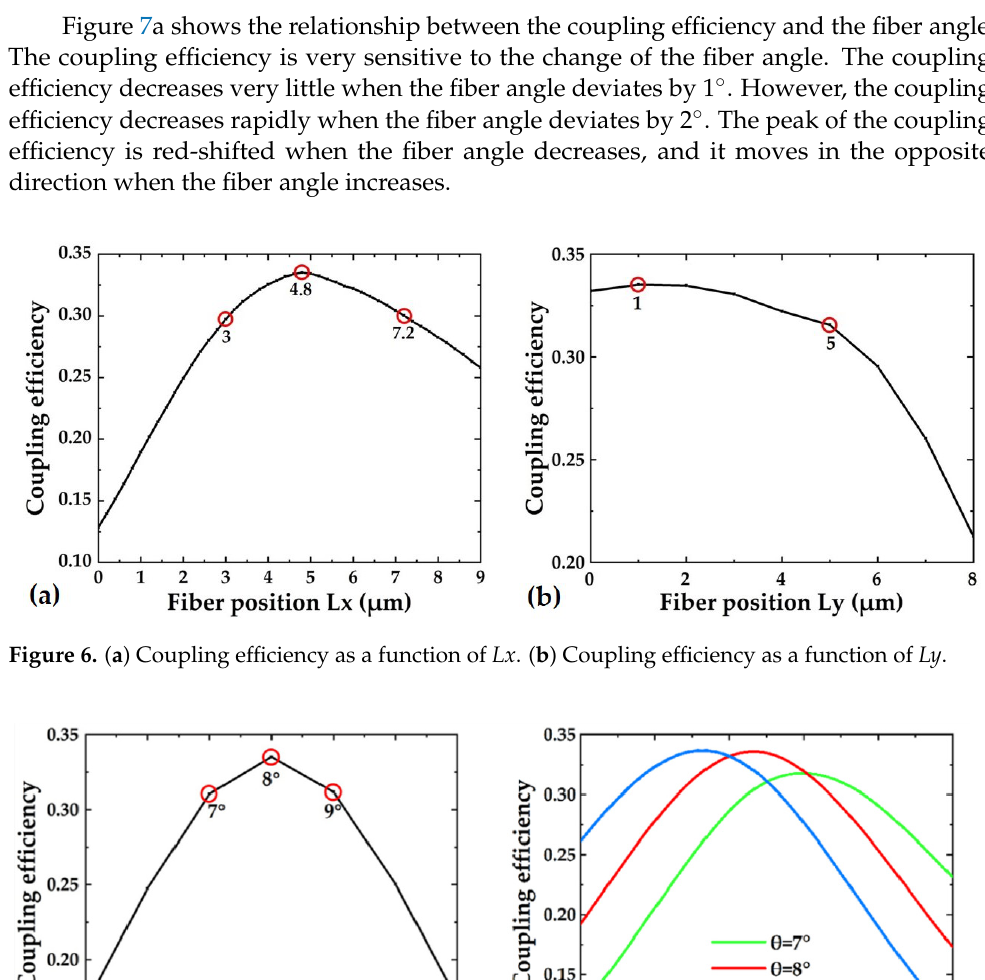
Figure 7. ( a ) Coupling efficiency as a function of the fiber angle. ( b ) Coupling efficiency as a function of the wavelength at different fiber angles.